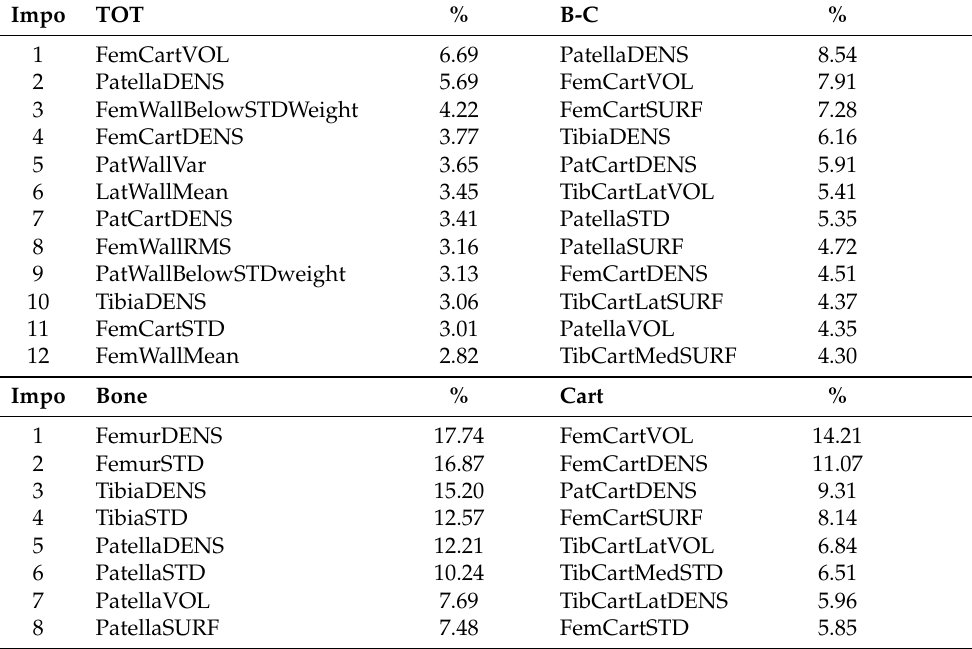
Table 5. Feature Importance: The most important features for all the feature selections (excluding WT-C) for the RF algorithm classification model (12 features for the TOT and B-C selections out of 51 and 24, respectively). The percentage of importance for each parameter in the corresponding feature selection is shown. All eight features are presented for the bone selection and eight out of sixteen for the cartilage selection. “DENS” stands for density and when “Cart” is not mentioned in the name of the feature it means that the bone value is considered. STD refers to the DENS